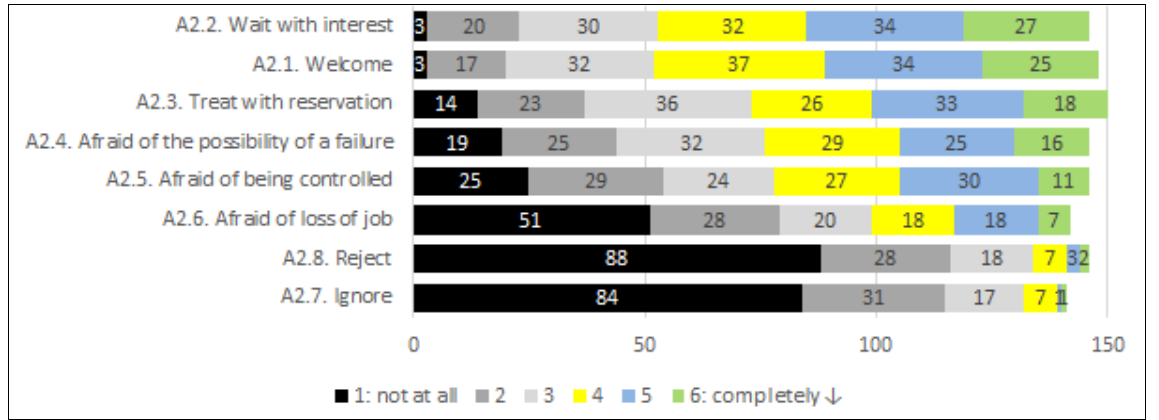
Figure 6. The typical attitude of employees regarding to the implementation of CDTs (A2, n=141-150)